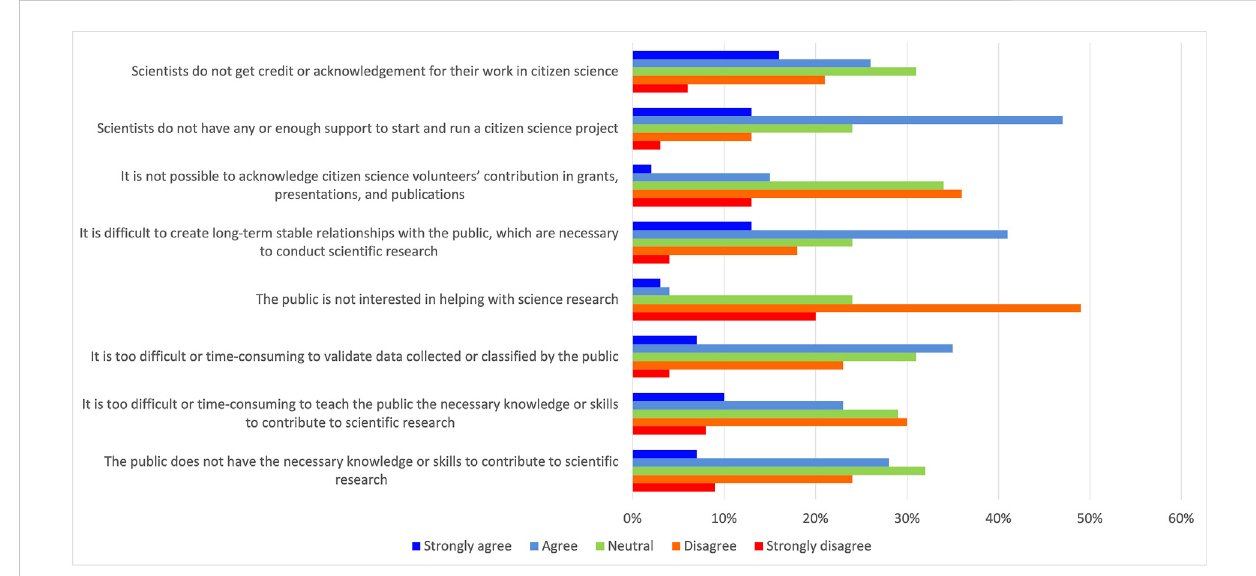
FIGURE 4 Percentage of respondents who disagreed/agreed with possible barriers to CS.